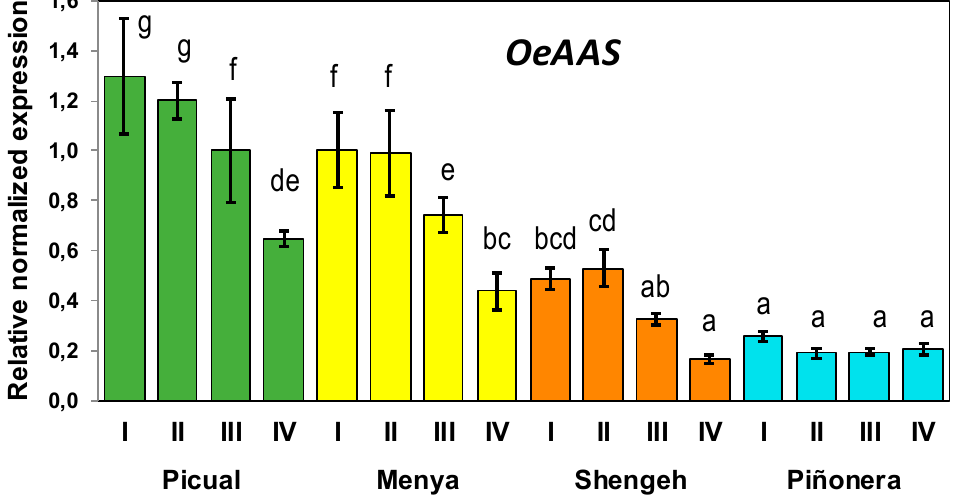
Figure 5. Relative expression levels of olive AAS gene in the mesocarp tissue of olive fruits (Picual, Menya, Shengeh, Piñonera cultivars) along fruit ripening. Data are mean ± SD. Three biological and two technical replicates were obtained for each sample. Different letters indicate statistically significant differences according to Tukey’s test ( p ≤ 0.05).